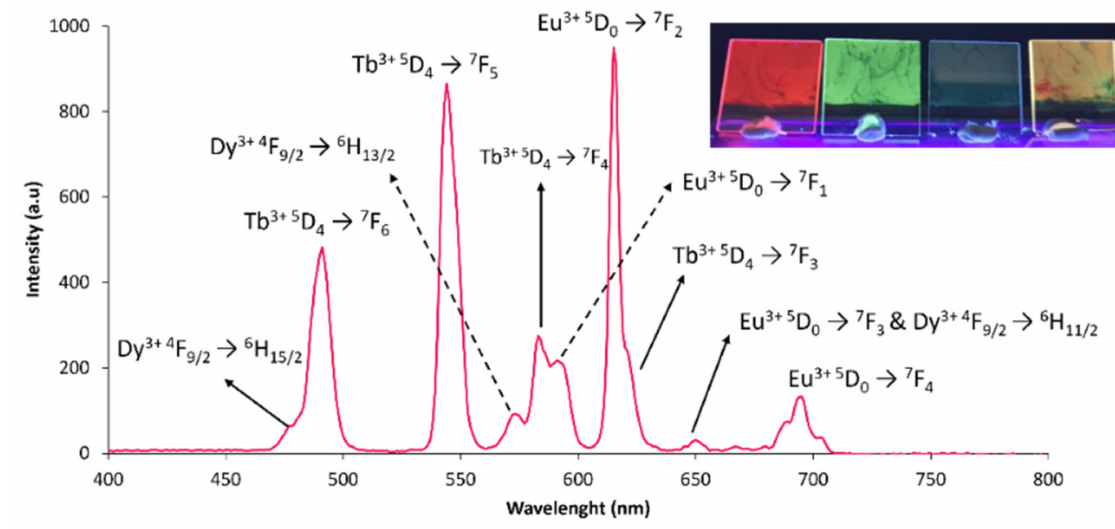
Figure 5. Mixed multilayered Eu( 1 ) 3 :Tb( 1 ) 3 :Dy( 1 ) 3 LB film fluorescence spectrum showing most of the distinct Ln 3+ transitions. Insert: monolayer and multilayered LB films of Eu( 5 ) 3 , Tb( 5 ) 3 , Dy( 5 ) 3 and Eu( 1 ) 3 :Tb( 1 ) 3 :Dy( 1 ) 3 is shown on the right under shortwave UV irradiation ( λ ex = 254